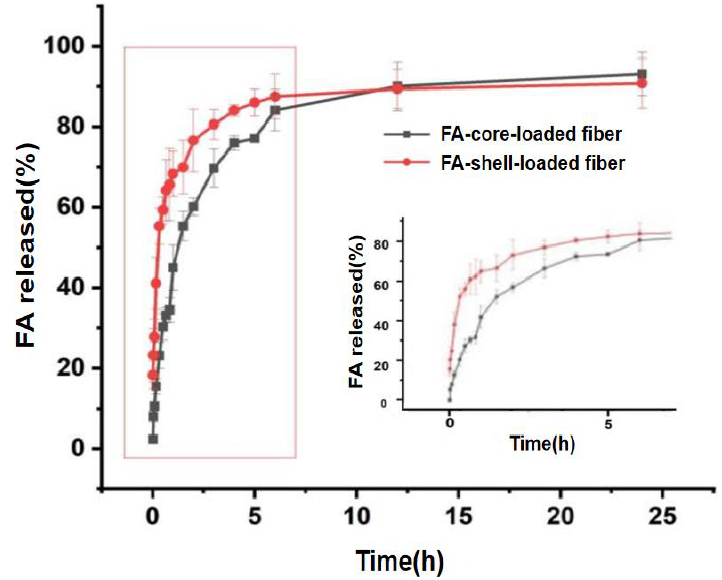
Figure 10. Analysis of the dissolution curve of FA and its local magnification.